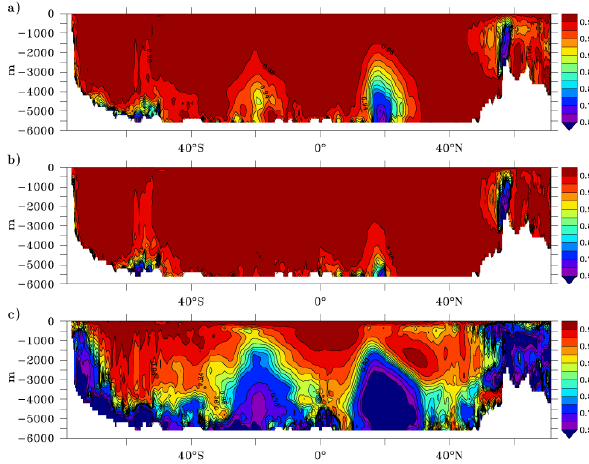
Fig. 11. As Fig. 10 (a) , (b) , (c) but for global